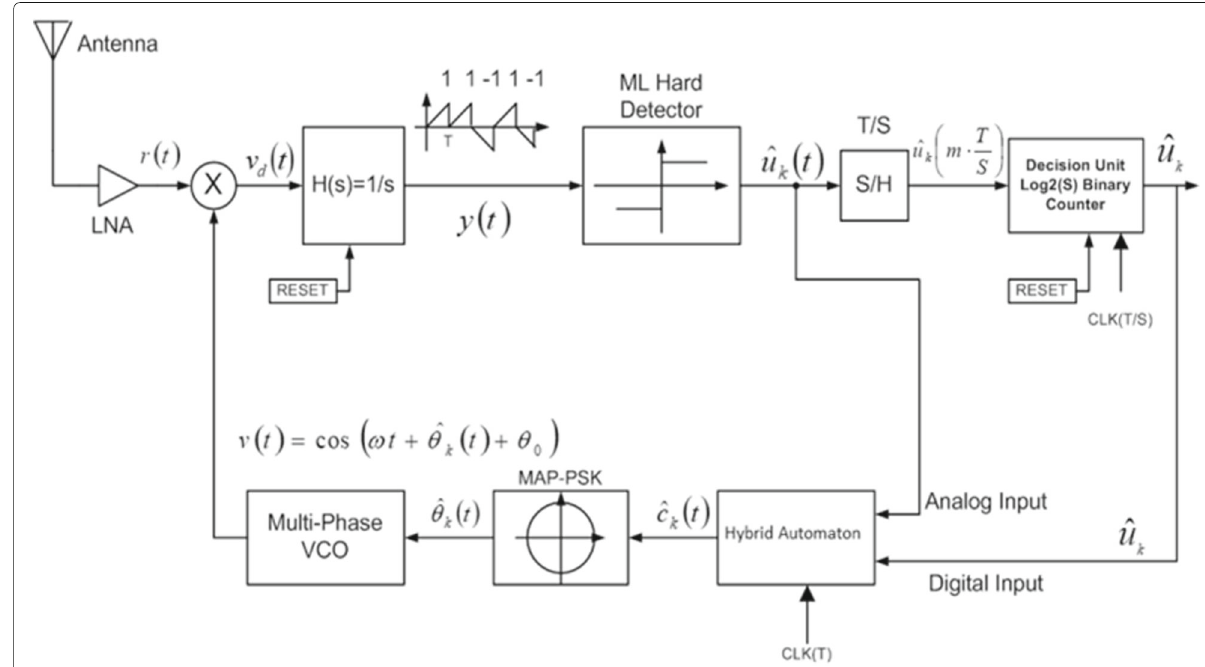
Fig. 2 The proposed coded symbol recovery loop using oversampling. This mixed-signal system recovers the source data by analog estimation, oversampling, and majority